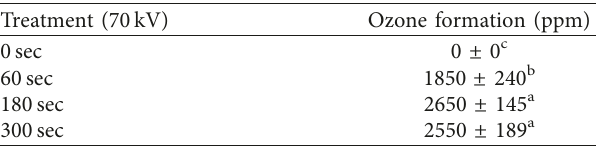
Table 1: Effect of cold plasma treatment time on ozone formation (Draeger tube method) in chicken breast fillet packages (mean ±